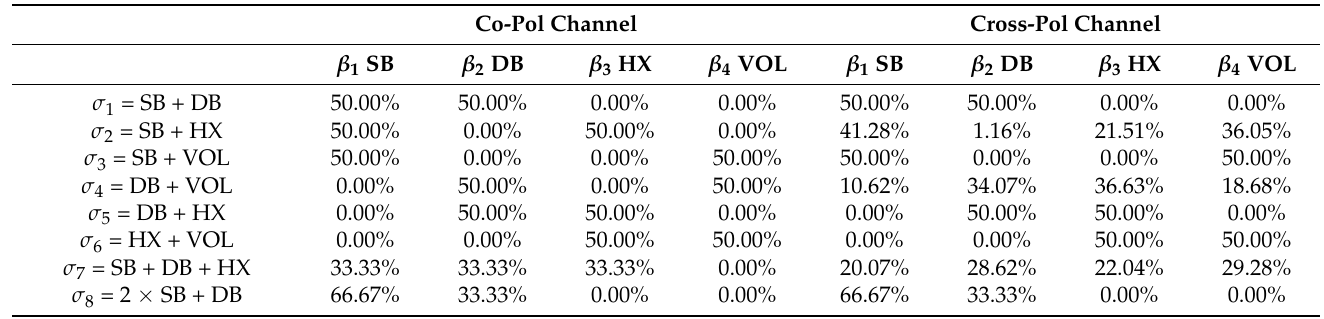
Table 6. Results of SIRT-based decomposition for linear combinations of synthetic signatures (co- and cross-polarized channels). Recognized signatures are specified in